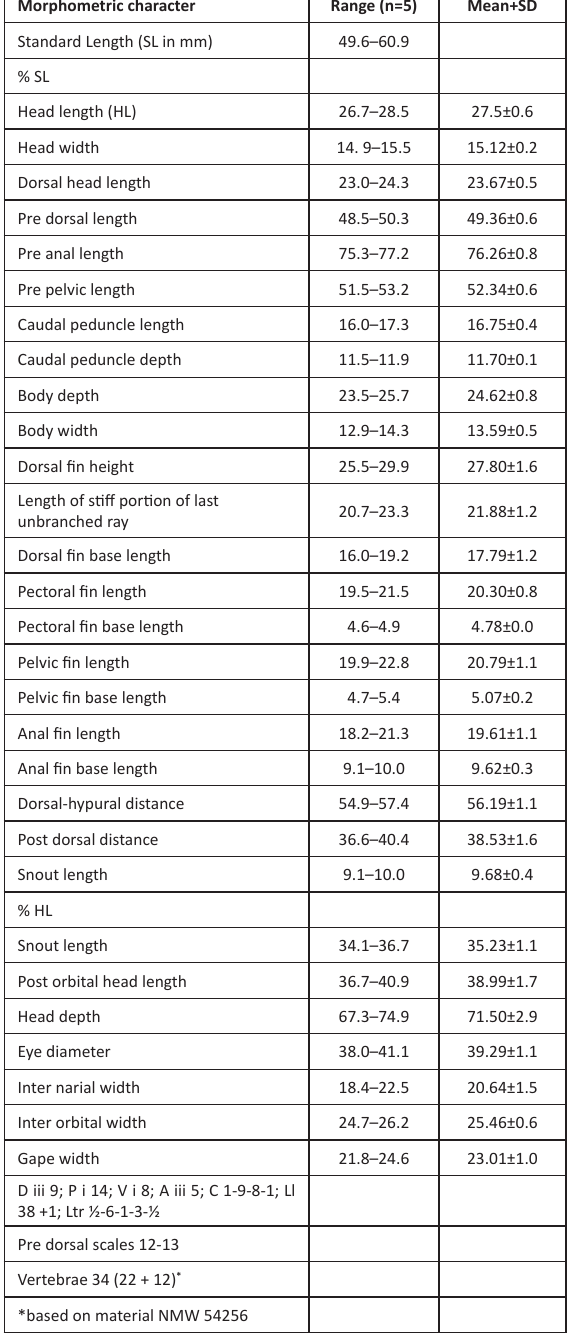
Table 2. Morphometric characters of Hyselobarbus lithopidos collected from Chandragiri River, Kerala Morphometric character Range